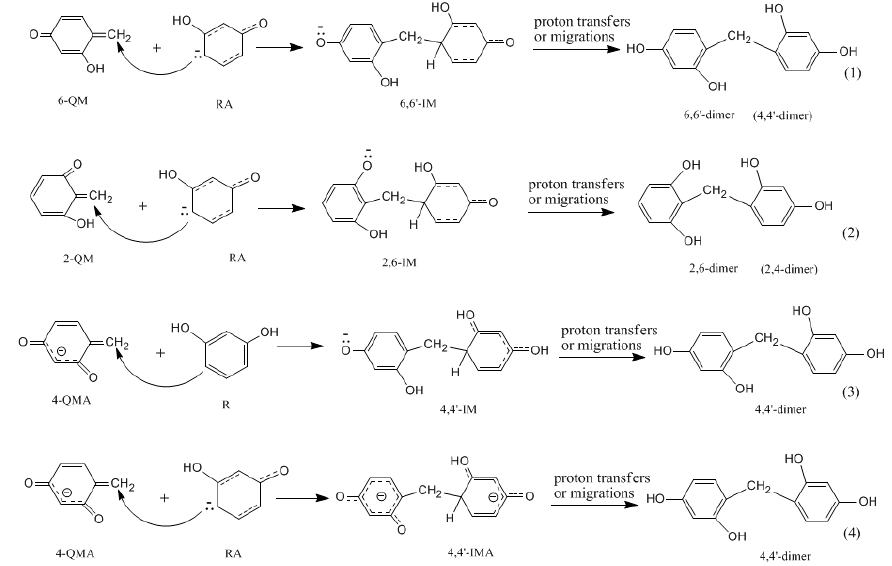
Figure 10. The selected Michael addition reactions of resorcinol anion (RA) and neutral resorcinol (R) with quinonemethides.